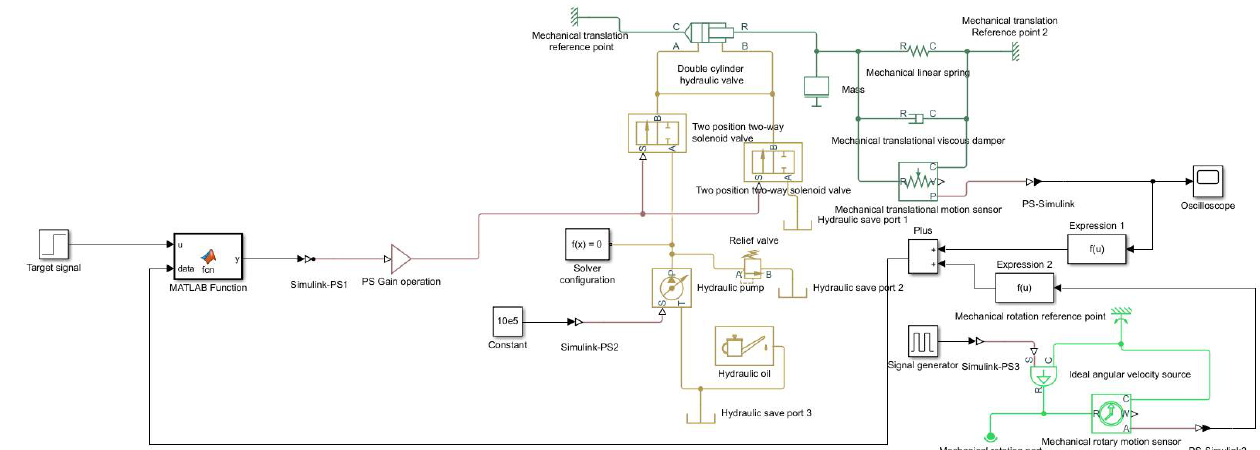
Figure 9. Simulink simulation model of the lifting system.